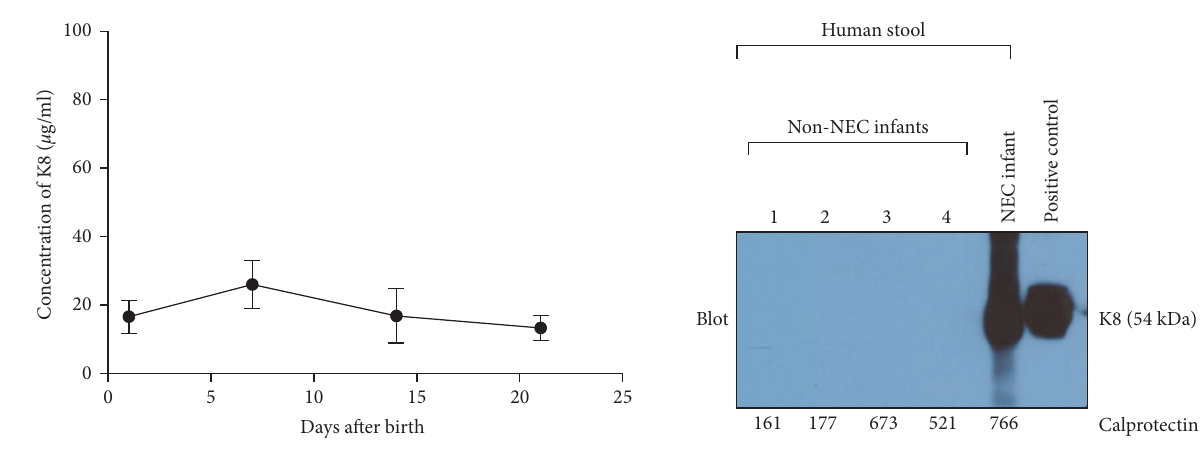
F IGURE 5: Western blot results of fecal K8 from healthy or NEC infants. All non-NEC infants with either low (161 and 177ng/ml) or high (673 and 521ng/ml) fecal calprotectin had a negative fecal K8 (lanes 1 – 4). Positive fecal K8 was identi fi ed in NEC infants (lane 5). HT29 cells are used as a positive control (lane 6). The results showed that fecal K8 has a higher speci fi city for NEC than